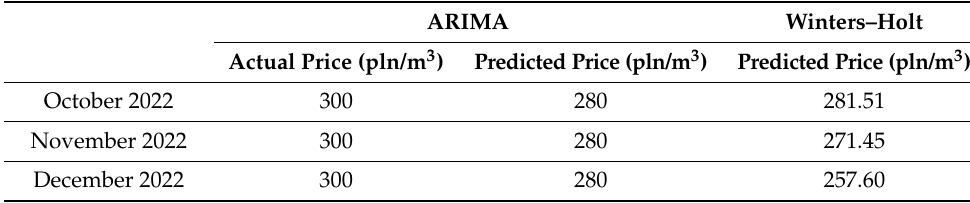
Table 6. Pine bark price prediction for the period from October–December